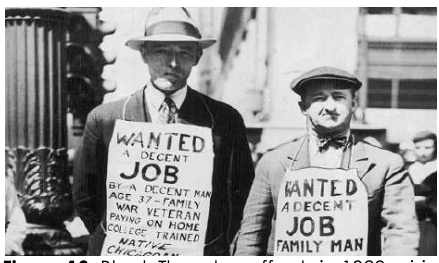
Figure 13. Black Thursday effects in 1929 crisis.